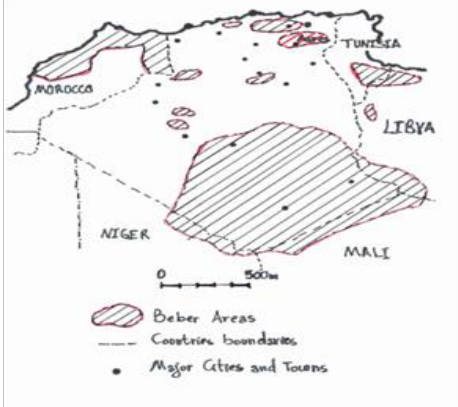
Figure 1. Map showing Berber area hatched. LEBBAL drawings.1989 (Developed by Authors).